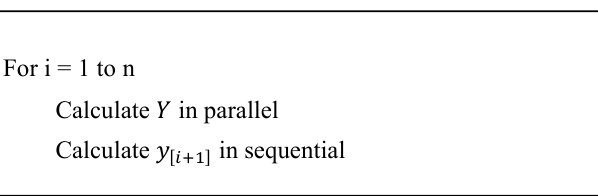
Figure 1. Implementation of the parallel Runge-Kutta algorithm. Stage values ( Y ) can be calculated in parallel but the step result needs to be calculated